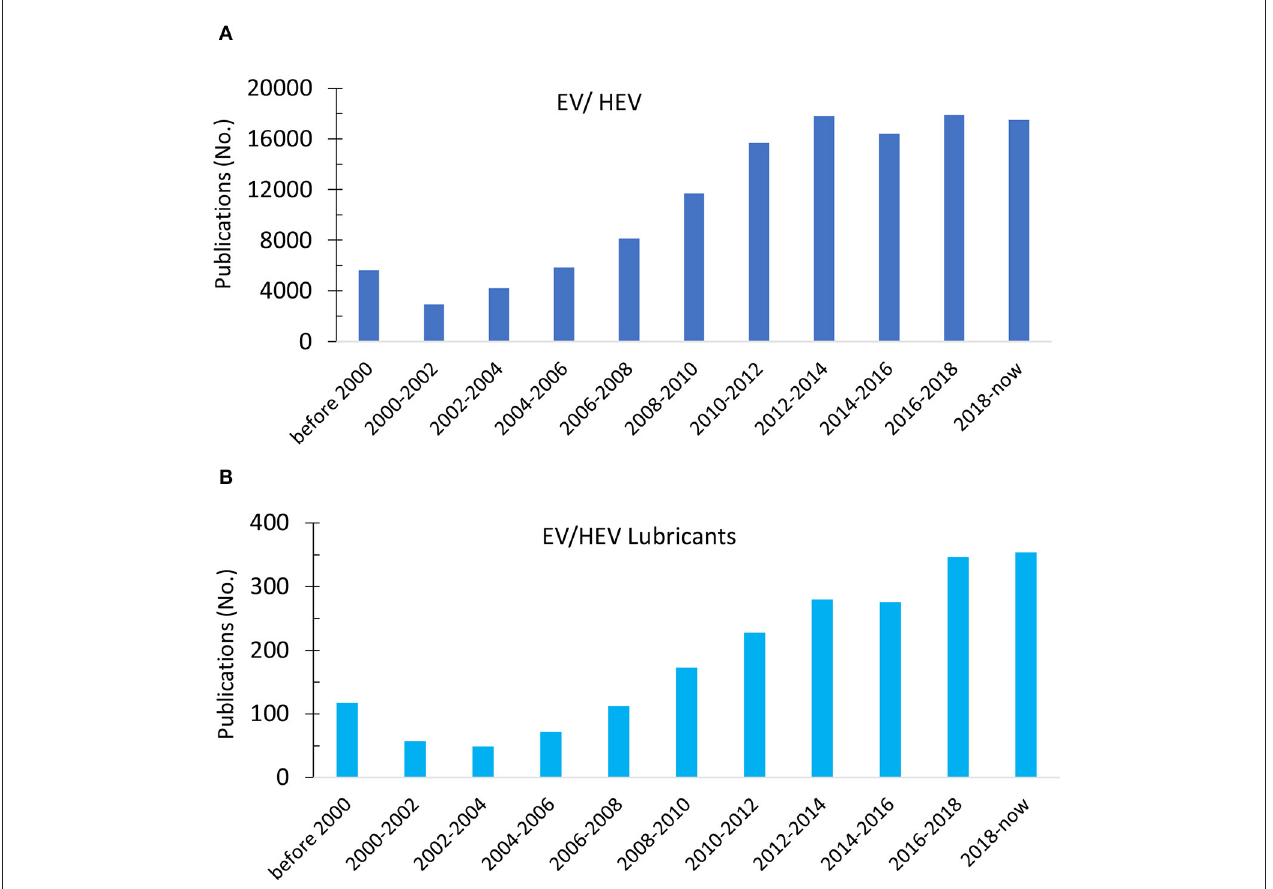
FIGURE 2 | The number of research publications and patents year wise for (A) EV/HEV and (B) EV/HEV lubricants. The x-axis shows the years. Data were collected through Google Scholar.